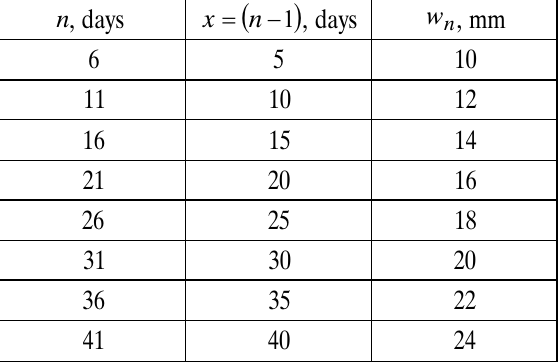
Table 3. Mathematical relationship among n , x , and n w syad, syad,